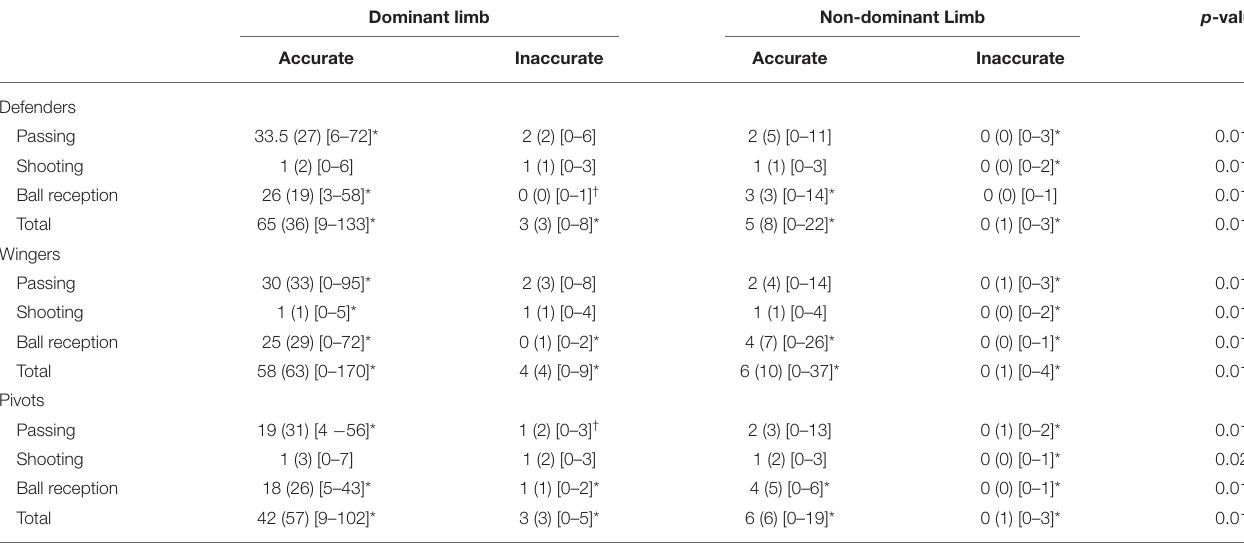
TABLE 3 | Median, interquartile range, and extreme values regarding the frequency counts (i.e., absolute number; a.u.) of technical parameters using dominant and non-dominant limb, computed according to positional